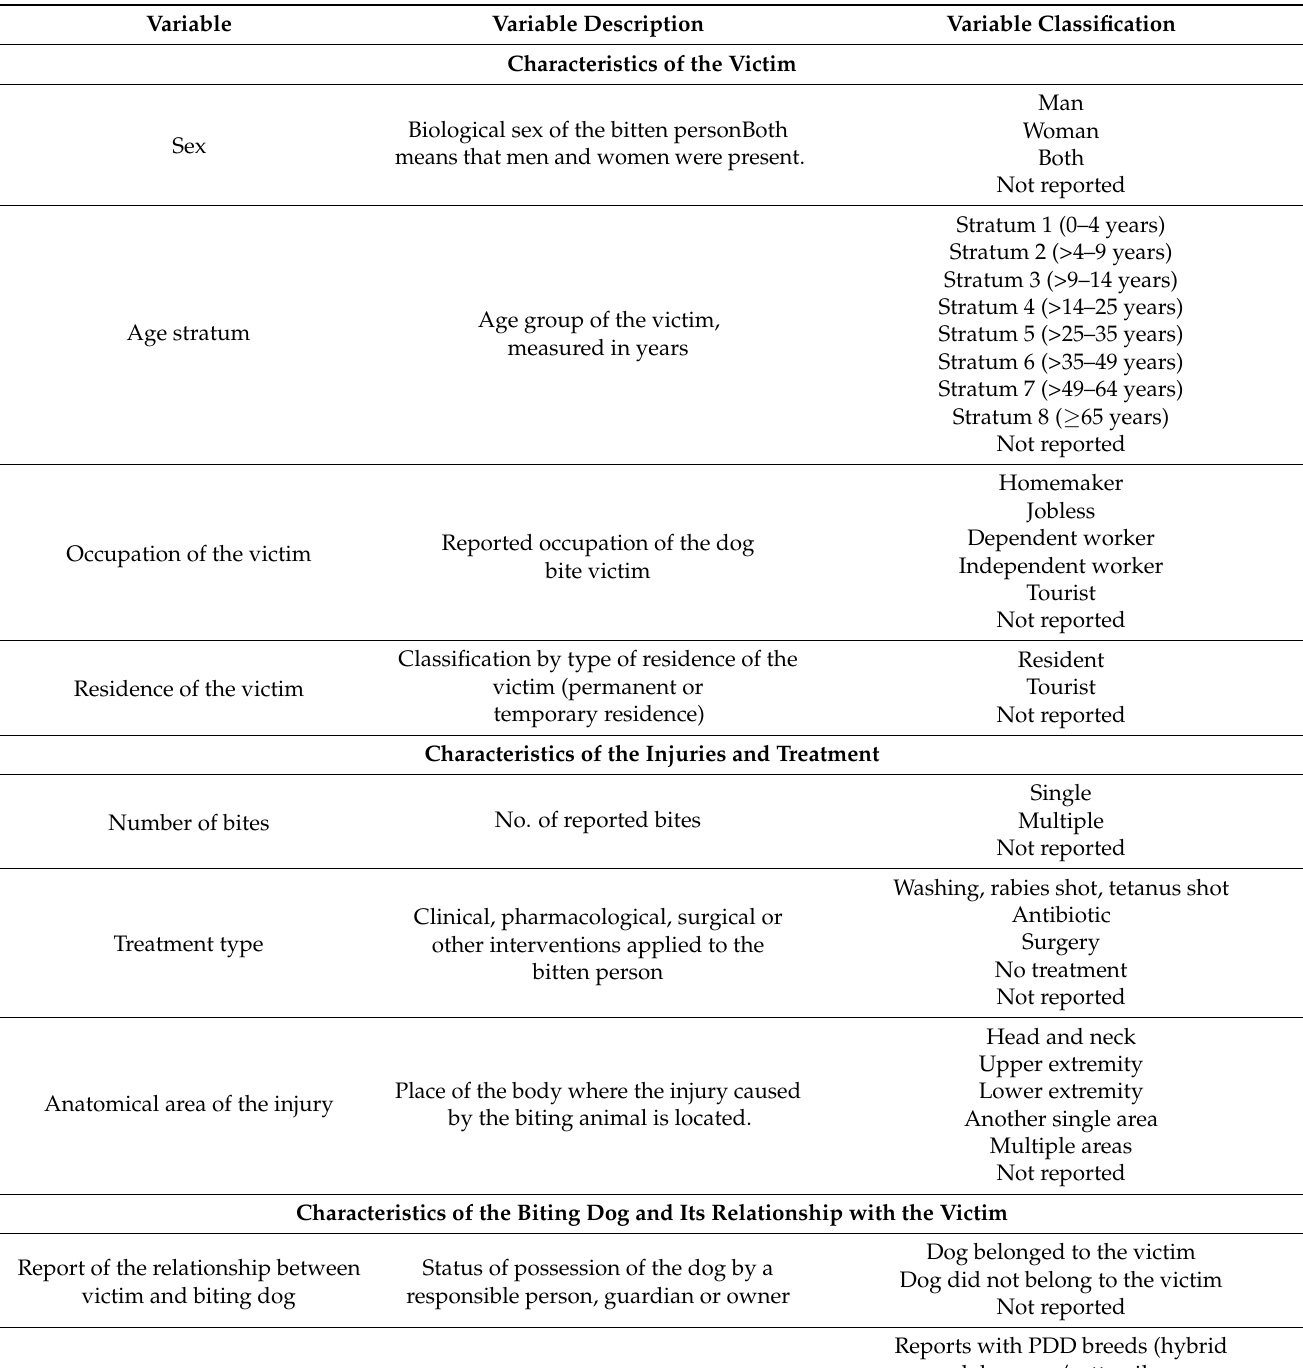
Table 3. Classification of the variables of interest selected for the